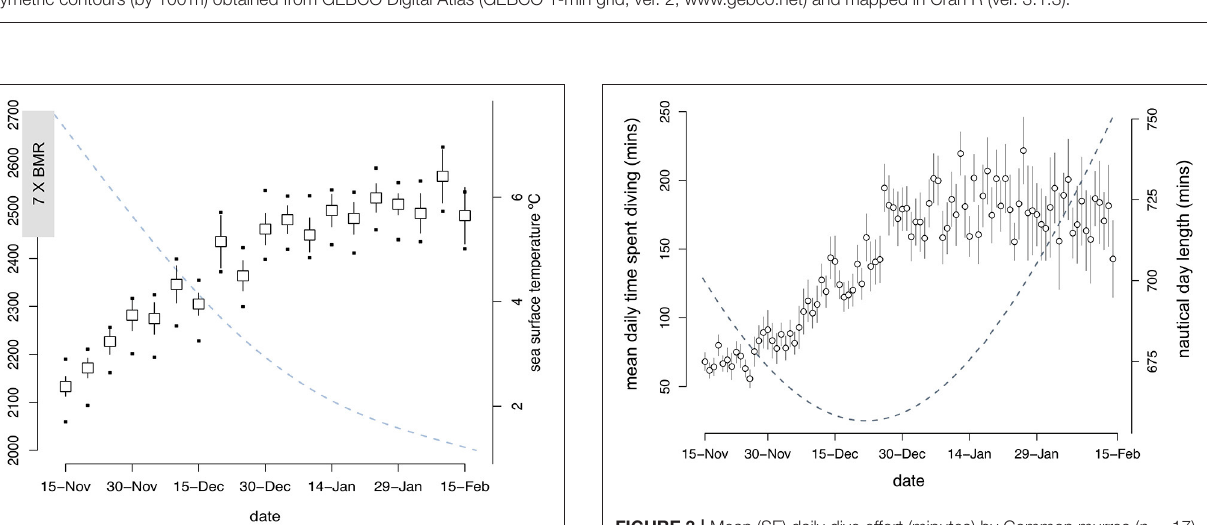
P < 0.0001] and dives were significantly deeper in LW (59.8